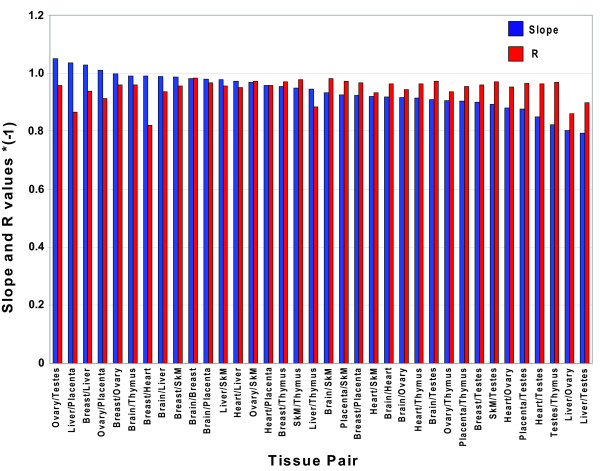
Slope and R values for all 36 tissue pair plots. The slopes and R values for the orthogonal fit lines for all 36 possible tissue pairs plotted in Figure 3 and Additional Files 8, 9, 10, 11, 12, 13, 14, 15 are ordered by the slope values. Slopes are shown in blue and R values are in red.